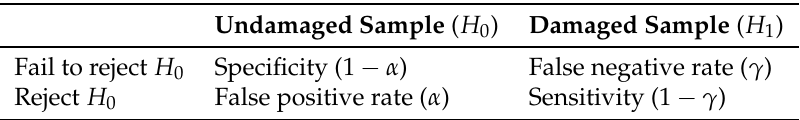
Table 7. Relationship between type I and type II errors.